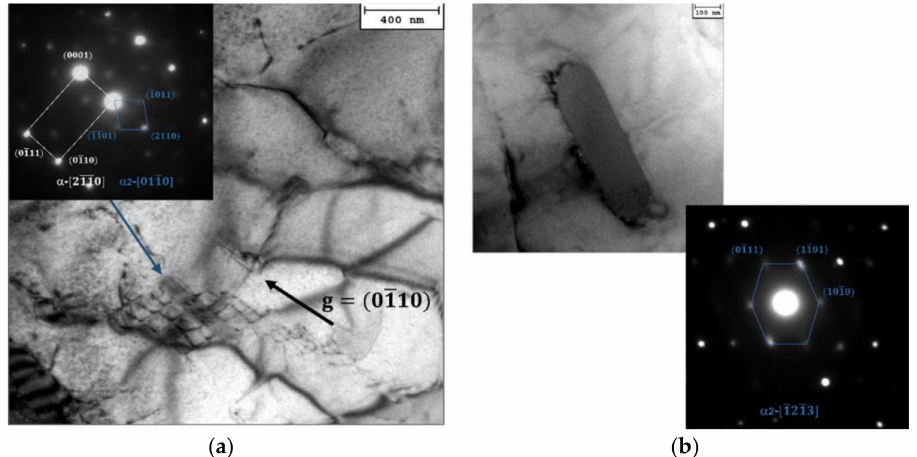
Figure 10. TEM micrographs of the sample head after 187 h at 650 ◦ C showing in ( a ) the presence of α 2 , whose crystallographic relationship with the parent α phase is reported in the inset SAEDP; ( b ) typical size of the α 2 phase